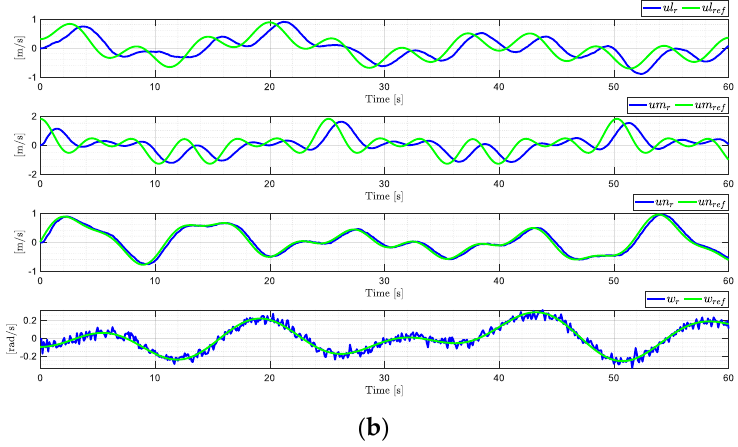
Figure 4. Identification of dynamic parameters. ( a ) Identification scheme; ( b ) Identification data signals.